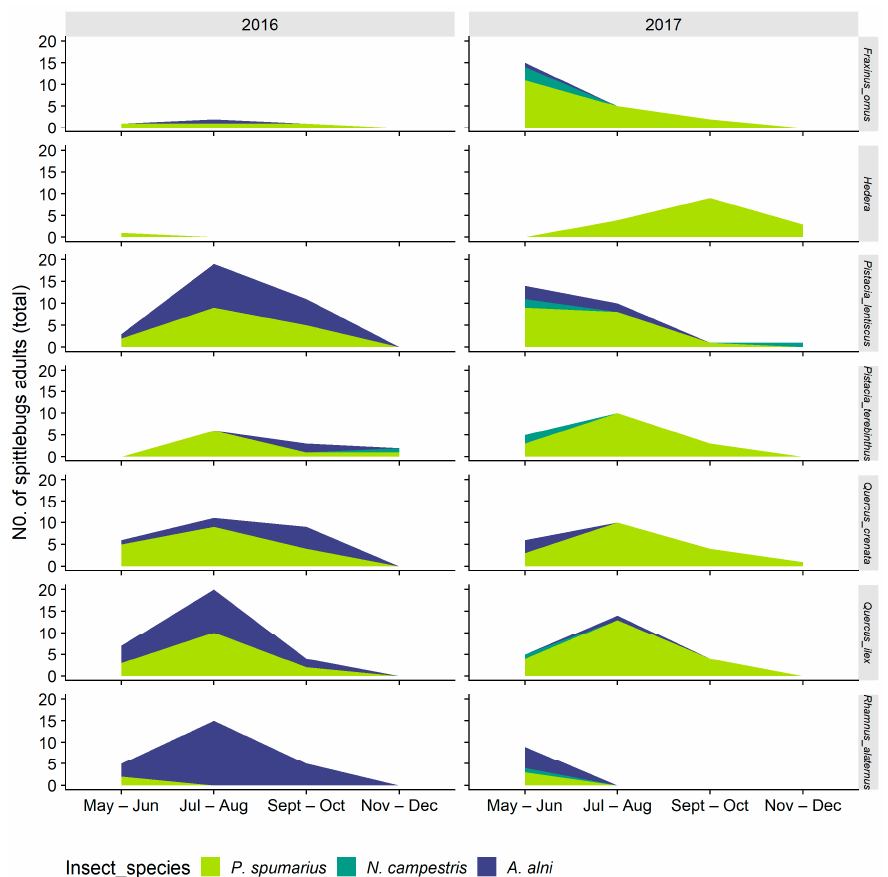
Figure 11. Abundance of spittlebug adults of different species ( Philaenus spumarius , Neophilaenus campestris , Aphorphora alni ) on di ff erent wild woody plant species in Liguria olive groves throughout the year. Insects 2020 , 11 , x FOR PEER REVIEW